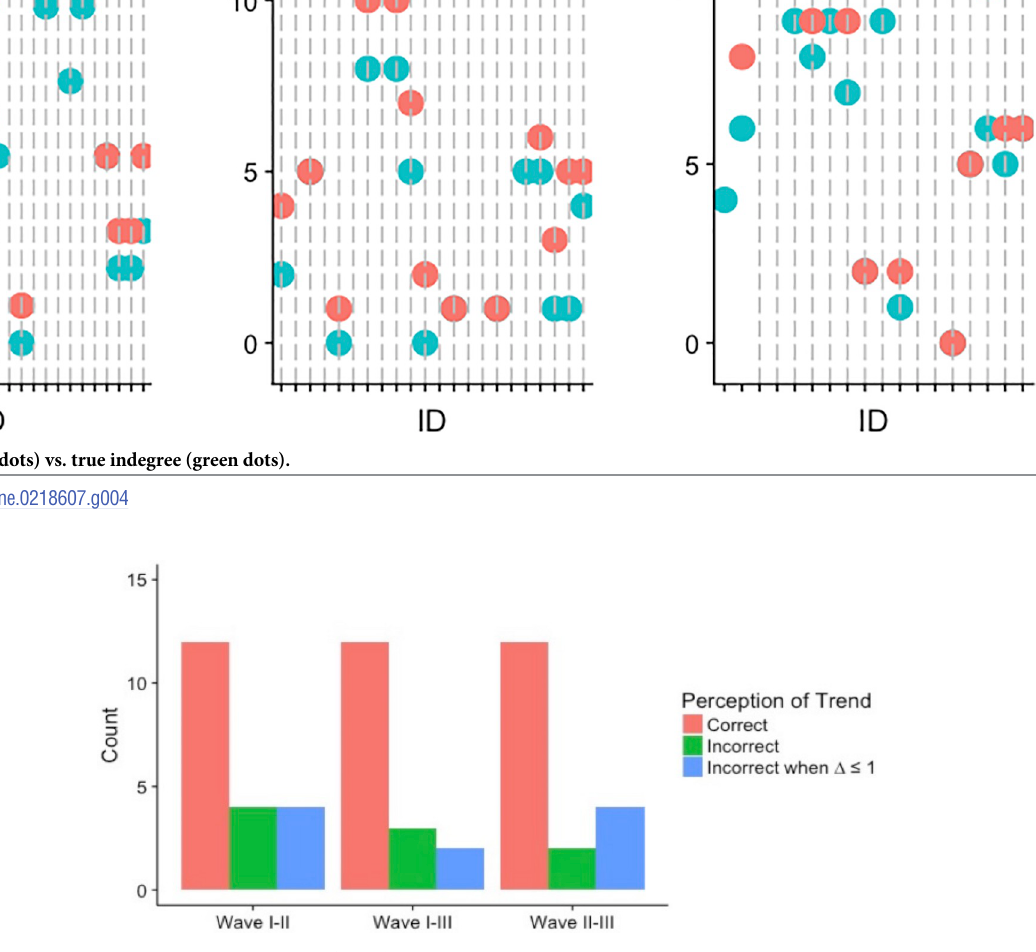
Fig 5. Perception accuracy of